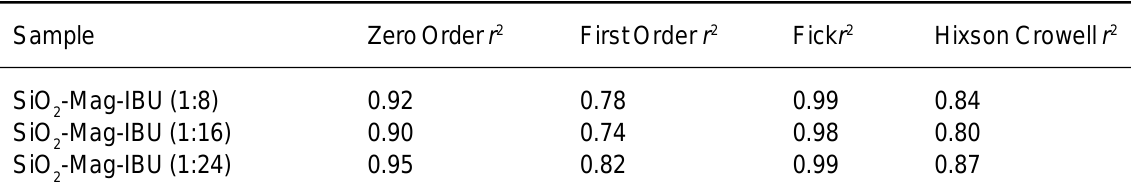
Table 6. Correlation coefficients ( r ) for linear relationship of the proposed combined kinetics of SiO IBU